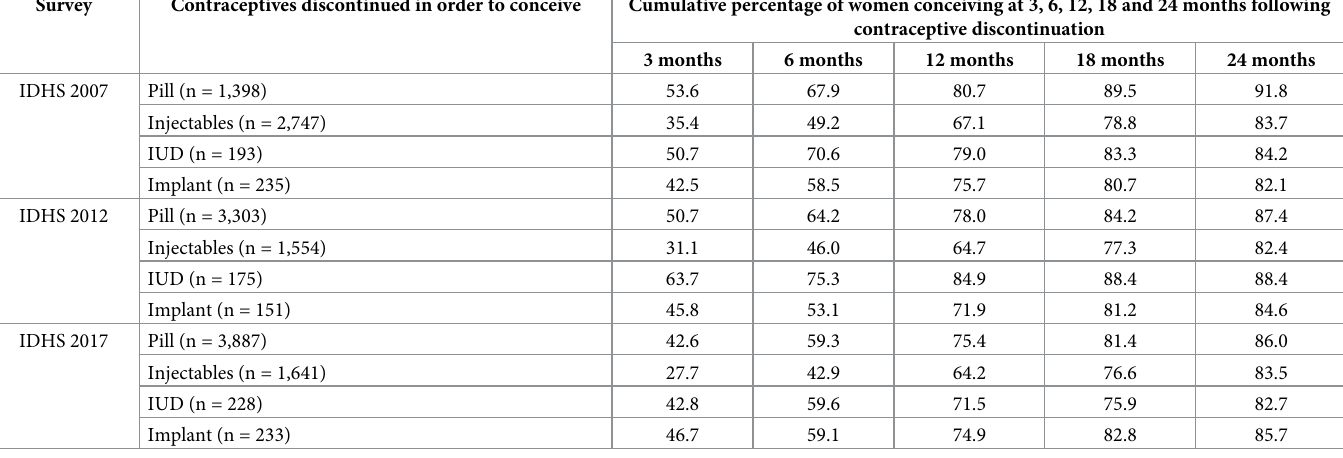
Table 2. Cumulative percentage distribution of women who discontinuing contraceptives due to desire to be pregnant by time to return to pregnancy following dis- continuation of pills, injectables, IUD and Implants. Indonesia 2007, 2012 and 2017. Survey Contraceptives discontinued in order to